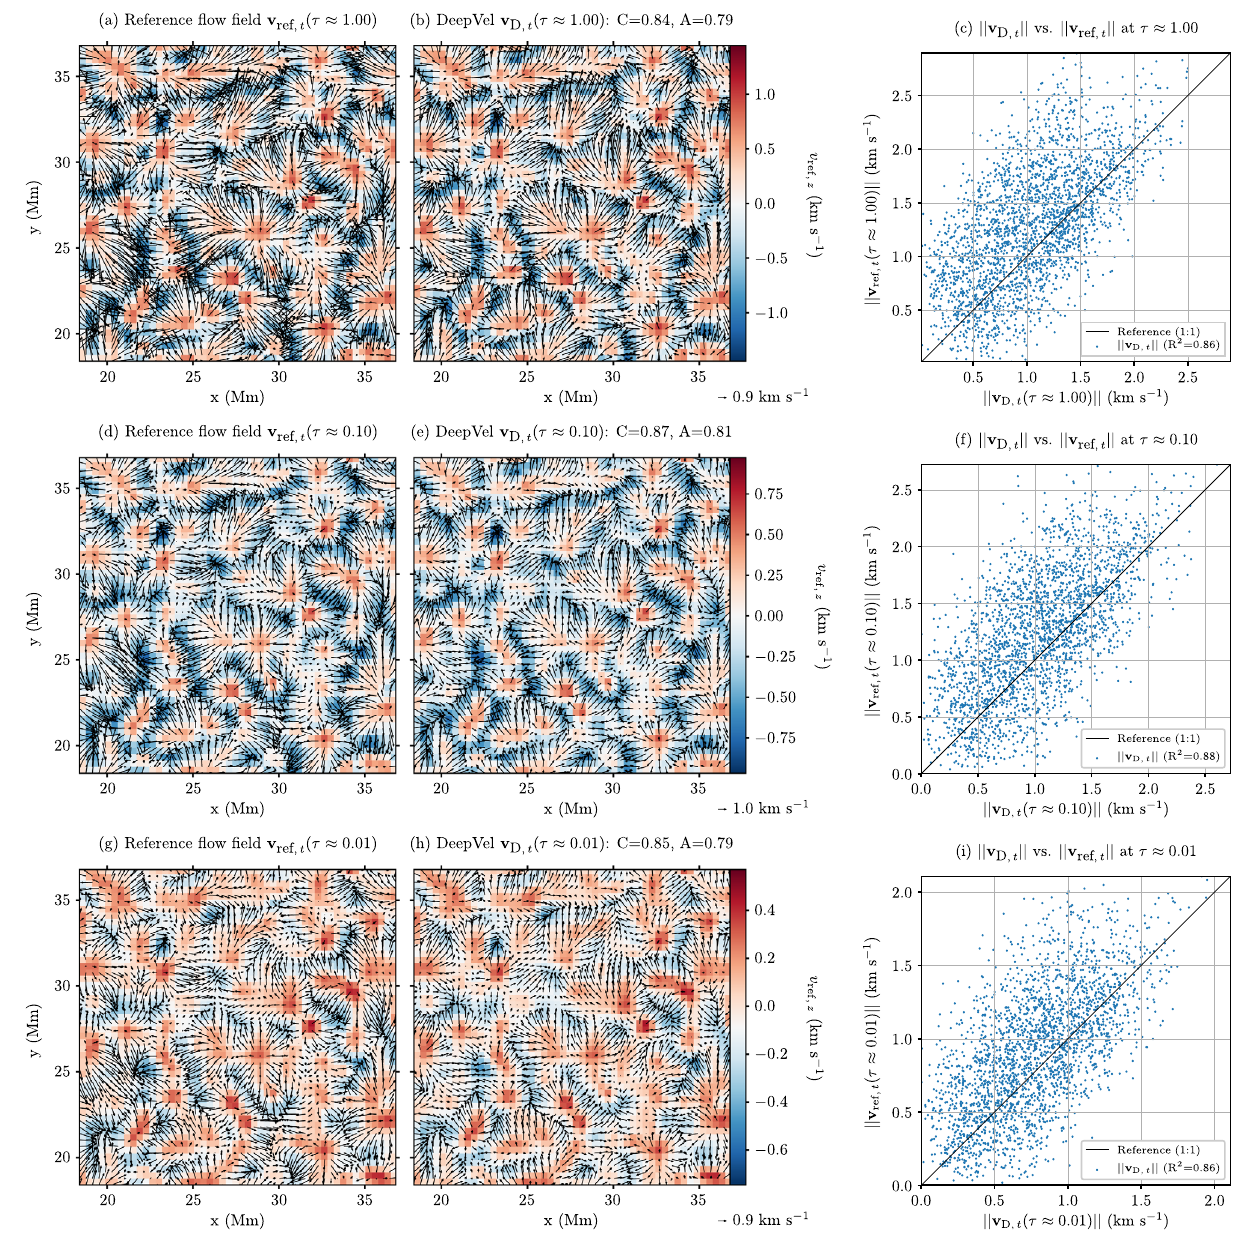
Fig. 1. Above the surface velocity inversions, STAGGER dataset. Patches of 50 by 50 pixels 2 extracted from the 30-min-averaged transverse velocity fi elds v D , t ( s , t i ) (left column) computed by the STAGGER simulation and (middle column) inferred by DeepVel at optical depths (top) s (cid:2) 1, (middle) s (cid:2) 0.1 and (bottom) s (cid:2) 0.01. The time-averaged vertical velocity v simulation and resampled to the SDO/HMI resolution is displayed as colored background. (Right column) Scatterplots comparing amplitudes || v D , t || to || v ref, t ||. The black line represents an ideal solution (i.e., a coef fi cient of determination R 2 =